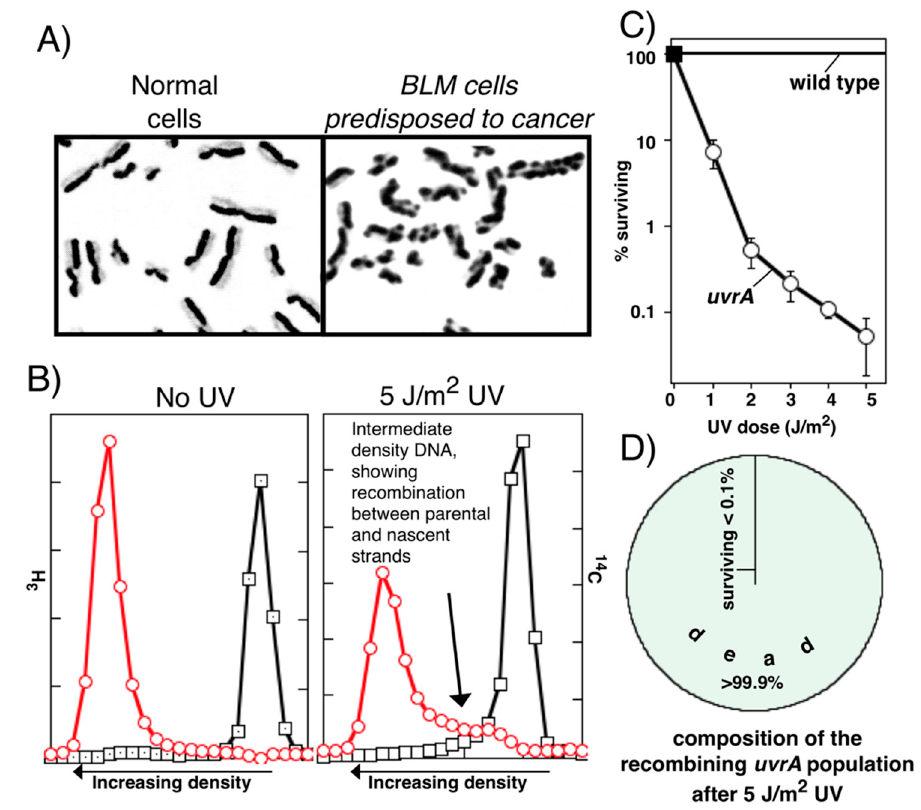
Figure 1. Recombination frequency during nonsexual cell cycles correlates with genomic instability and cell death. ( A ) One form of recombination, sister chromatid exchanges, can be observed directly by growing cultured cells in 5-bromo-deoxyuridine for two generations before staining with Giemsa. In healthy cells, few exchanges are observed. By contrast, in cells lacking BLM, a RecQ homolog, recombination events are observed more frequently, and patients are predisposed to developing cancer. RecQ in E. coli is similarly required to suppress illegitimate recombination from occurring [17]. Photos generously provided by S. Wolff and A. A. Sandberg. ( B ) Experiment demonstrating that